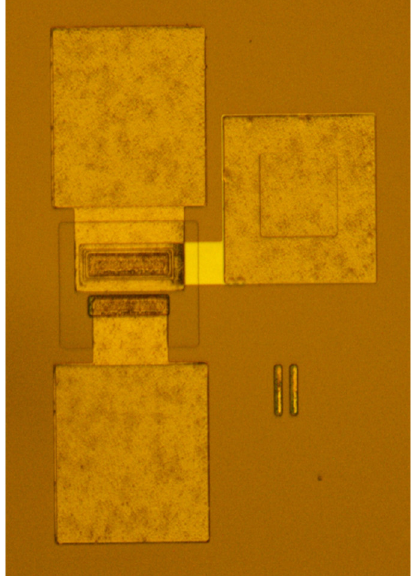
Figure 8. AlGaN/GaN HEMT device optical micrograph.